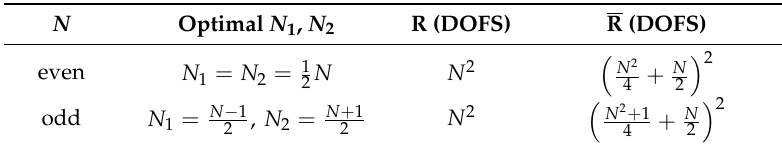
Table 1. DOFs of the adaptive